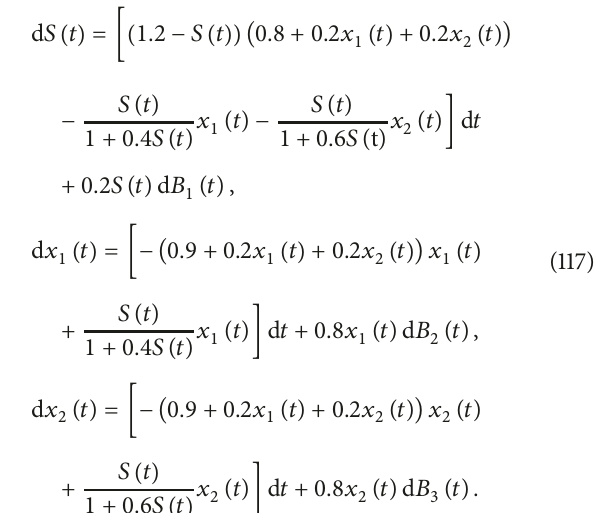
0.1913 (the black line in Figure 1(b)), and there exists a stationary distribution (see Figures 4(b) and 5(b)). This fluctuation phenomenon basically comes from the random factors which leads to variation of concentration for 𝑆(𝑡) and 𝑥 (𝑡) . The species 𝑥 (𝑡) will be extinct since the concentration 𝑖 2 of nutrient 𝑆 ∗ = 𝜆 1 = 0.3102 is less than its break-even concentration 𝜆 2 = 0.7128 (see Figure